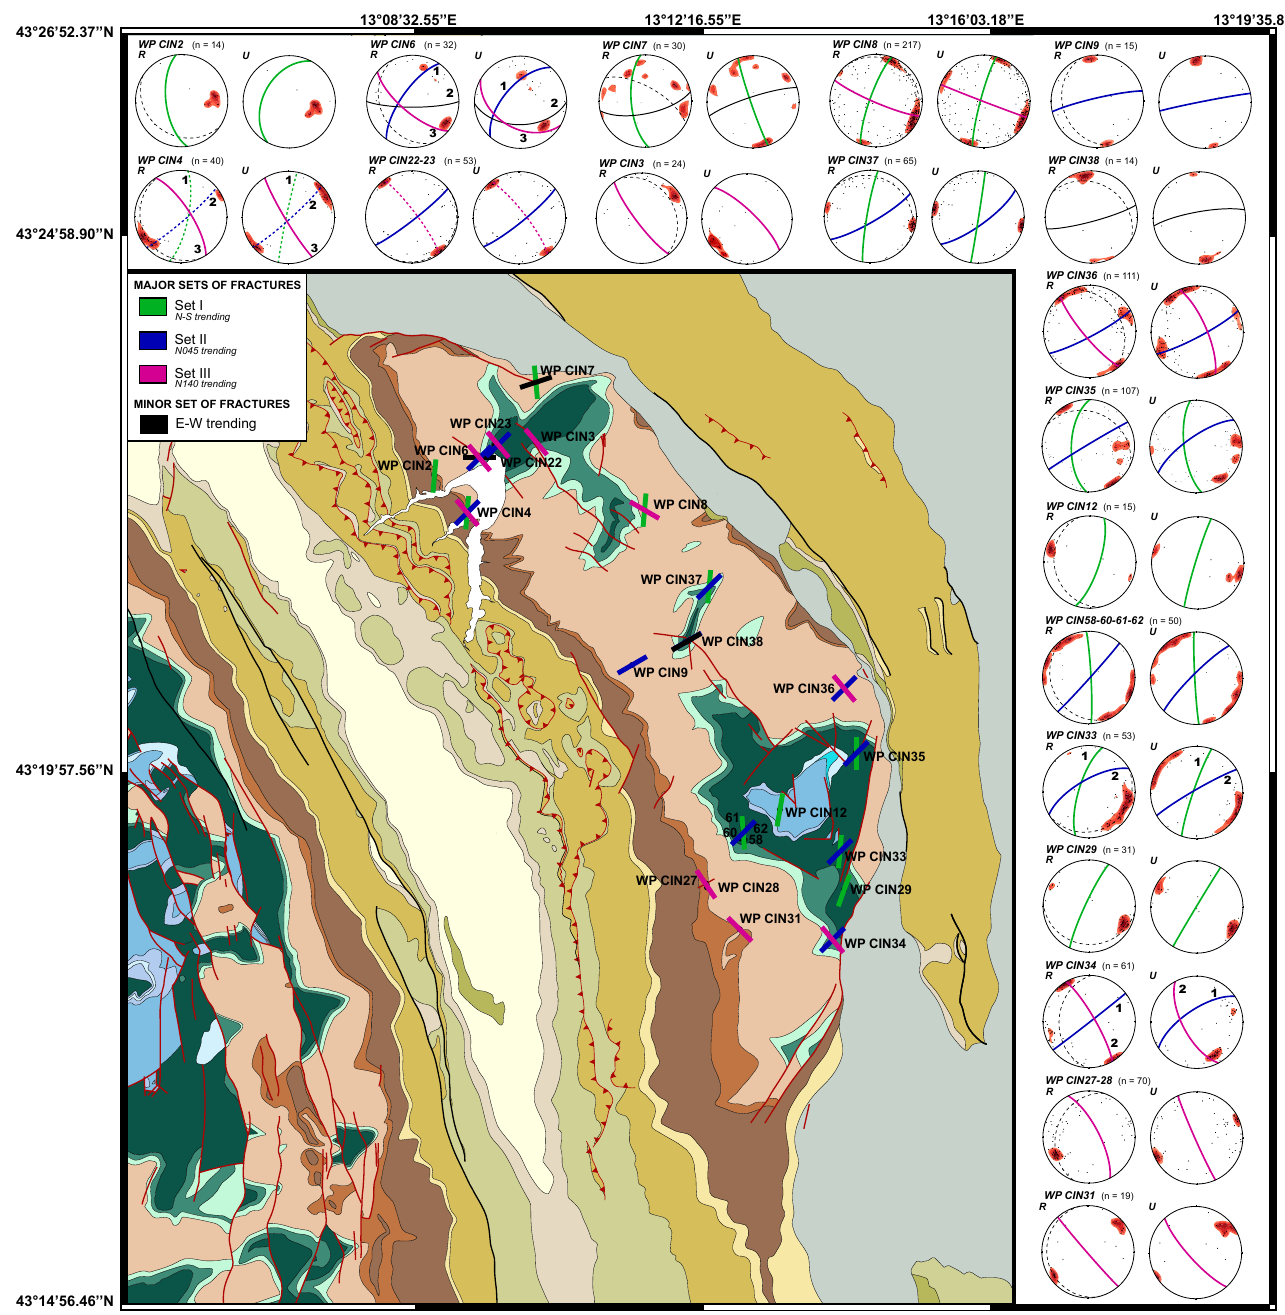
Figure 3. Location of fracture planes measured on the geological map (GPS locations are provided in the supplementary material, Table S2). Each measurement point is associated with two stereodiagrams (lower hemisphere), representing main fracture orientations in current (R) and unfolded attitude (U); on each stereodiagram, the bedding is reported as dashed lines, and fracture planes by solid-colored lines, each color relating to one of the three major fracture sets defined (green: set I, blue: set II, pink: set